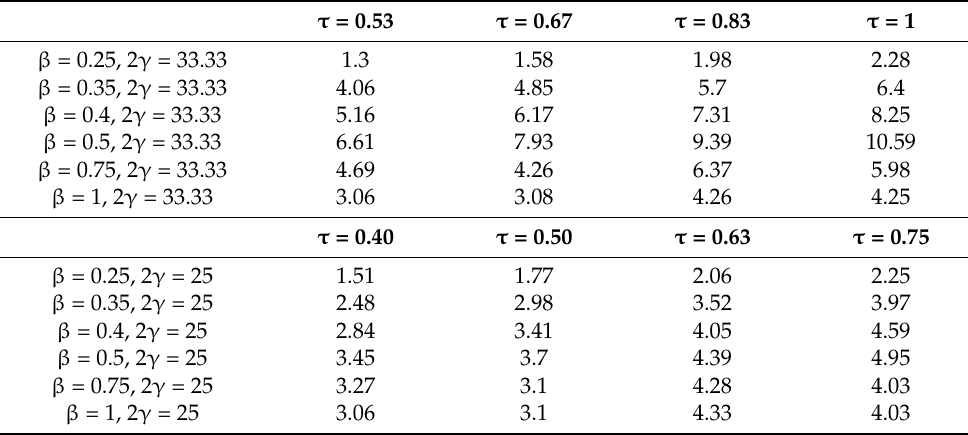
Figure 10. Influence of τ on peak SCFs. Table 12. Influence of τ on peak SCFs.